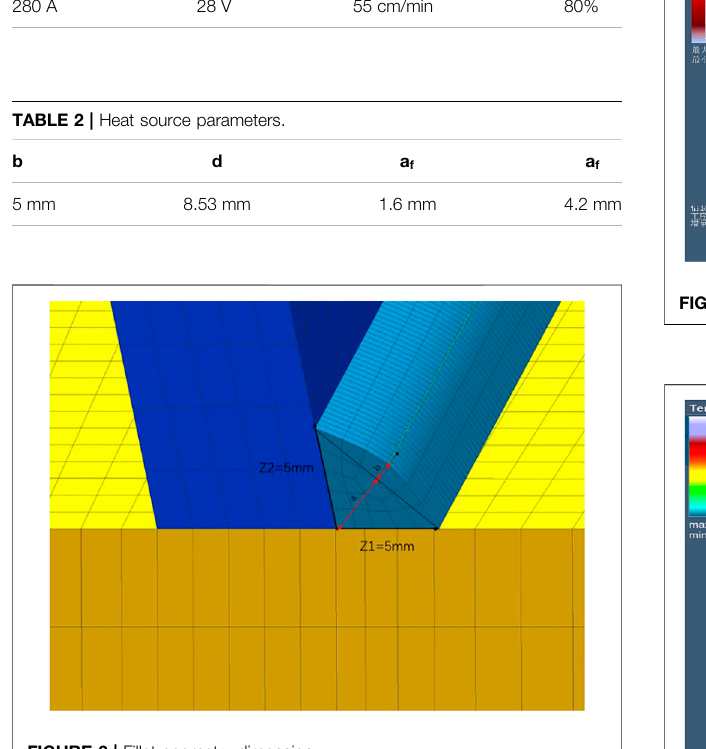
FIGURE 3 | Fillet geometry dimension. TABLE 3 | Fillet geometry.